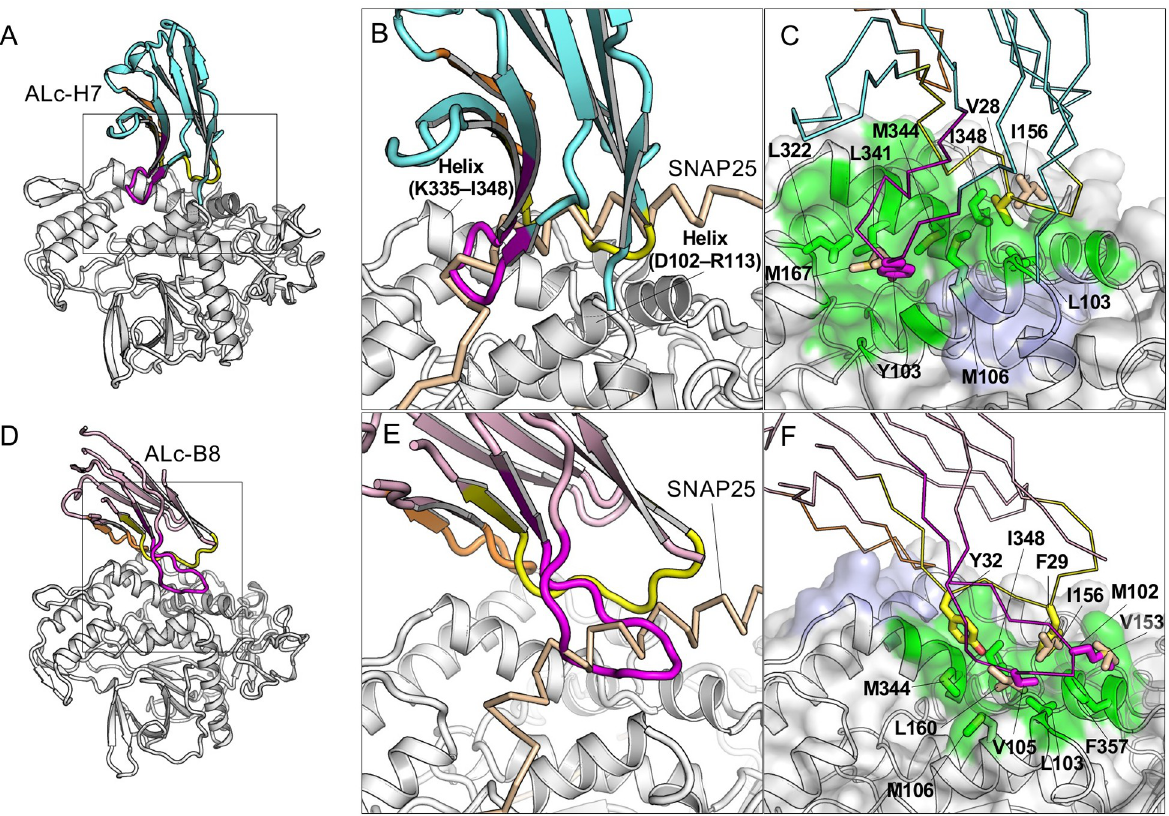
Fig 5. ALc-H7 and ALc-B8 block the interaction of SNAP25 to the a-exosite of LC/A. (A, D) Cartoon representation of ALc-H7 (A) or ALc-B8 (D) in complex with LC/A. The framework region of ALc-H7 and ALc-B8 are colored cyan and pink, respectively. The CDR1, 2, and 3 are colored yellow, orange, and magenta, respectively. (B, E) Superimposition of LC/A–ALc-H7 (B) or LC/A–ALc-B8 (E) with the SNAP25(146–204)-bound LC/A (PDB ID: 1XTG). Only the VHH-bound LC/A is represented. LC/A and SNAP25 are colored as that shown in Fig 3. (C, F) The VHH residues competing with SNAP25 residues for LC/A binding are drawn as sticks. The epitopes are colored as that shown in Fig